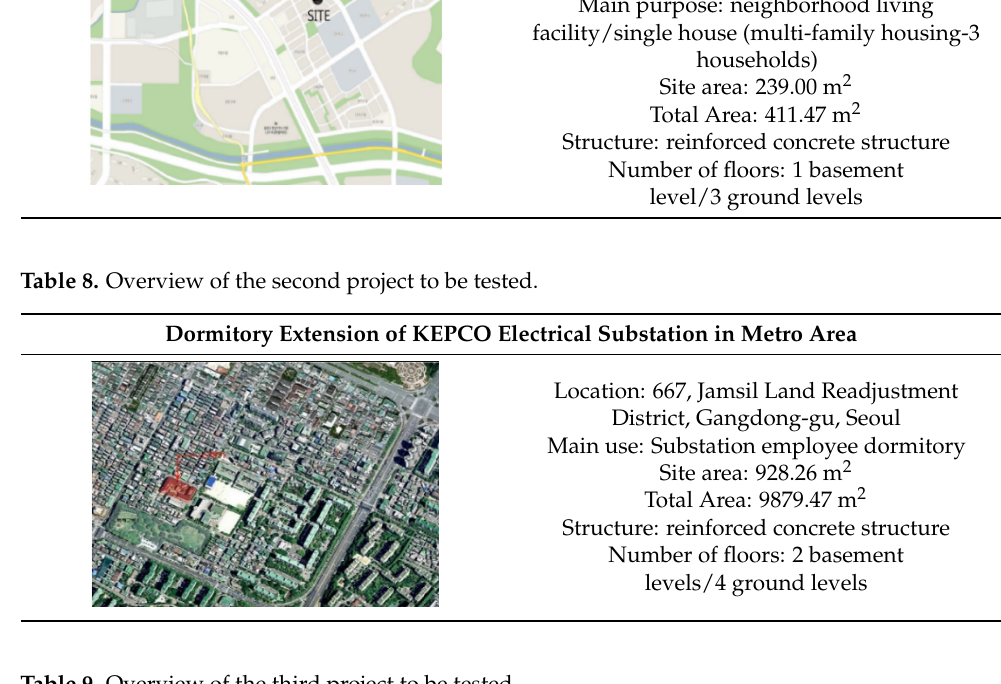
Table 9. Overview of the third project to be tested.